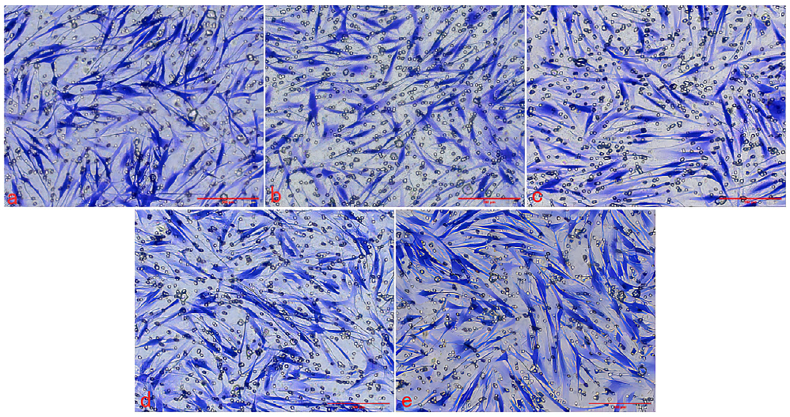
Figure 7. The Transwell cell migration map of HSFs labeled with GOQDs. ( a – e ) are 0 μ g/mL, 50 μ g/mL, 100 μ g/mL, 200 μ g/mL and 400 μ g/mL, respectively. Scale bars: 200 μ m.